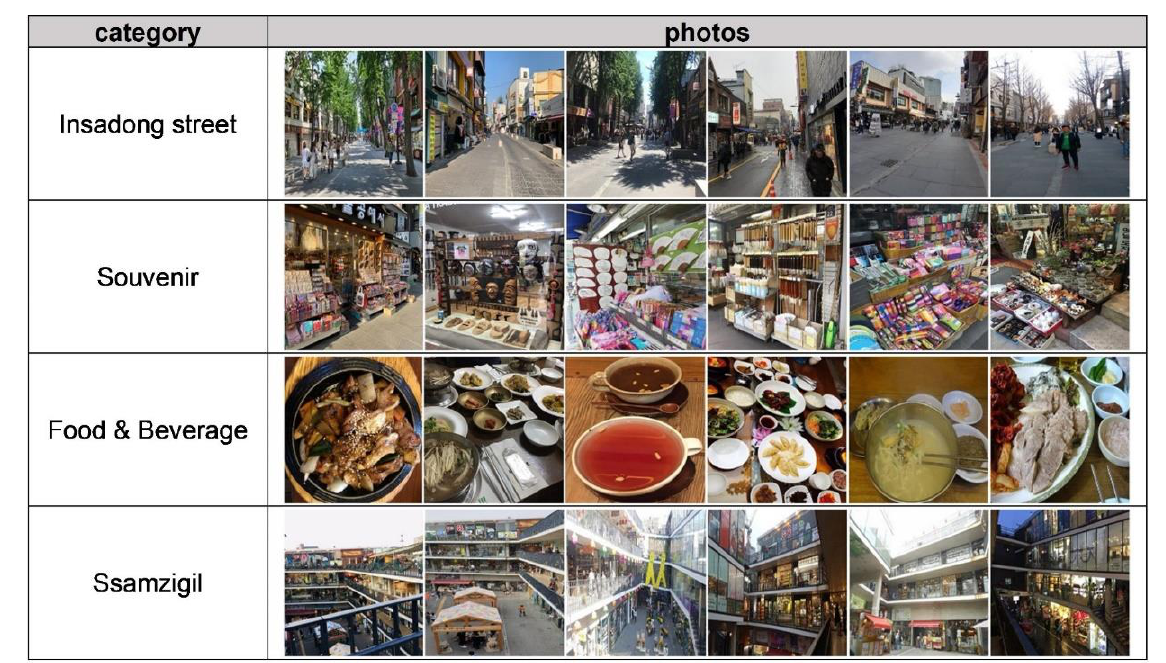
Figure 17. Example photos by category in Insadong.